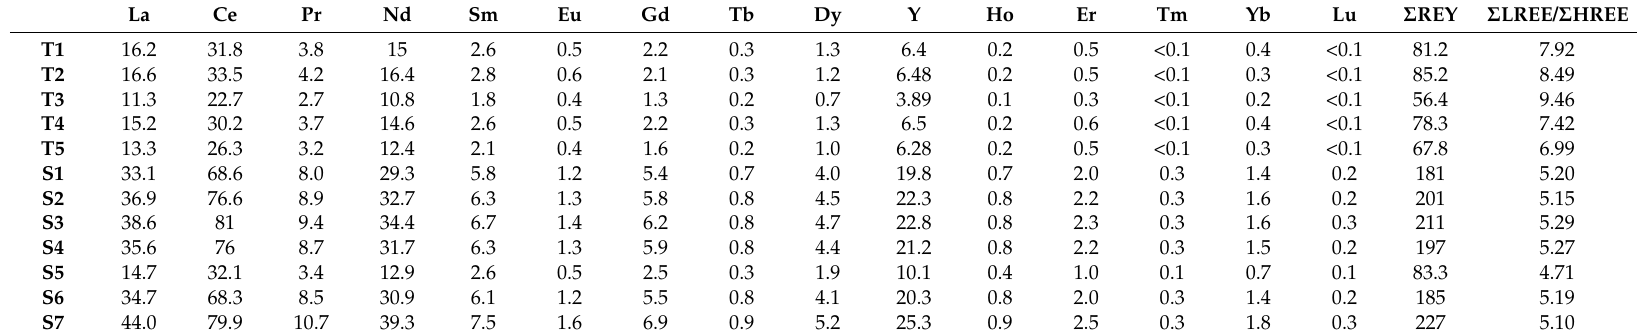
Table A4. Concentrations of REYs, expressed in mg kg − 1 , in the Telaš´cica Bay sediments (T1–T5) and surrounding soils